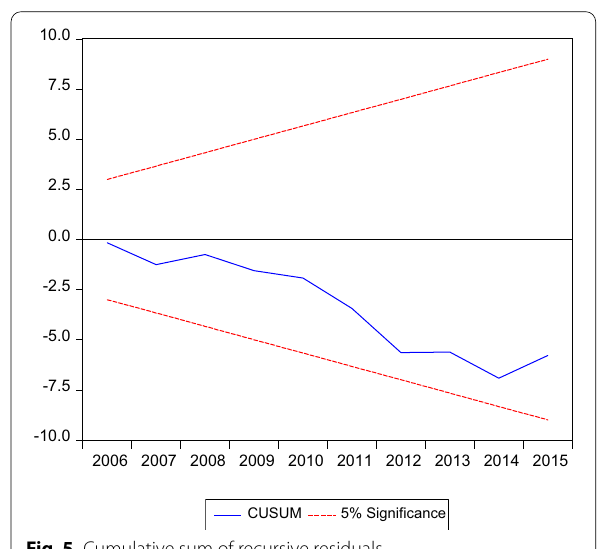
Fig. 5 Cumulative sum of recursive